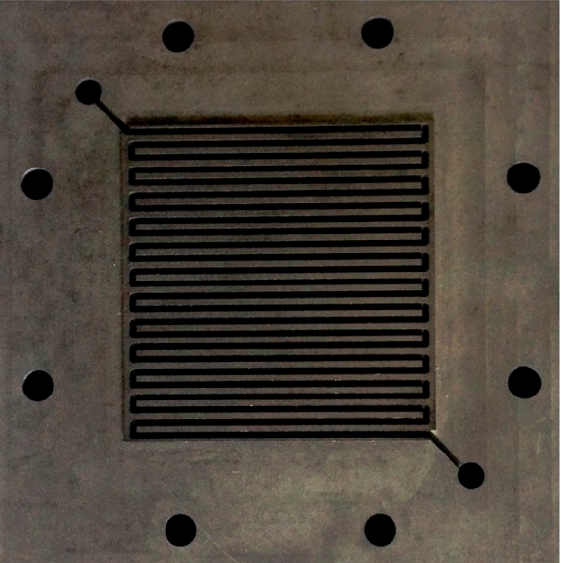
Figure 2. Serpentine flow fields. Reprinted from [26], copyright (2016), with permission from Else- vier.